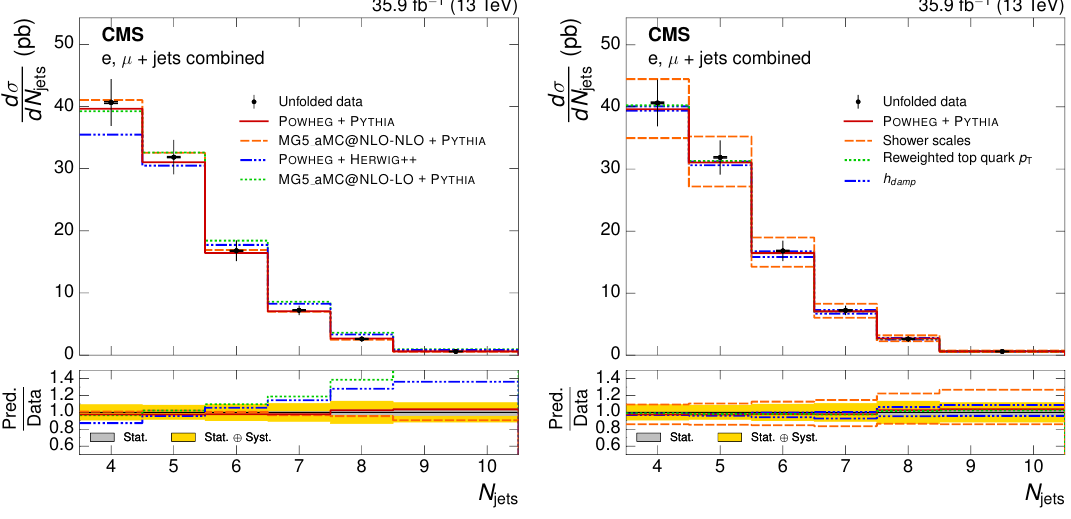
Figure 7 . Absolute N jets di(cid:11)erential tt cross section, compared to di(cid:11)erent tt simulations in the left plot, and compared to the powheg + pythia simulation after varying the shower scales, and h damp parameter, within their uncertainties, in the right plot. The vertical bars on the data represent the statistical and systematic uncertainties added in quadrature. The bottom panels show the ratio of the predictions to the